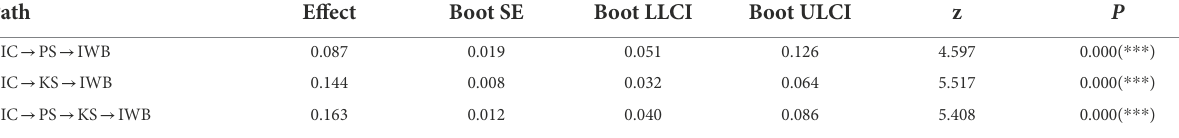
TABLE 5 Mediation effect analysis.